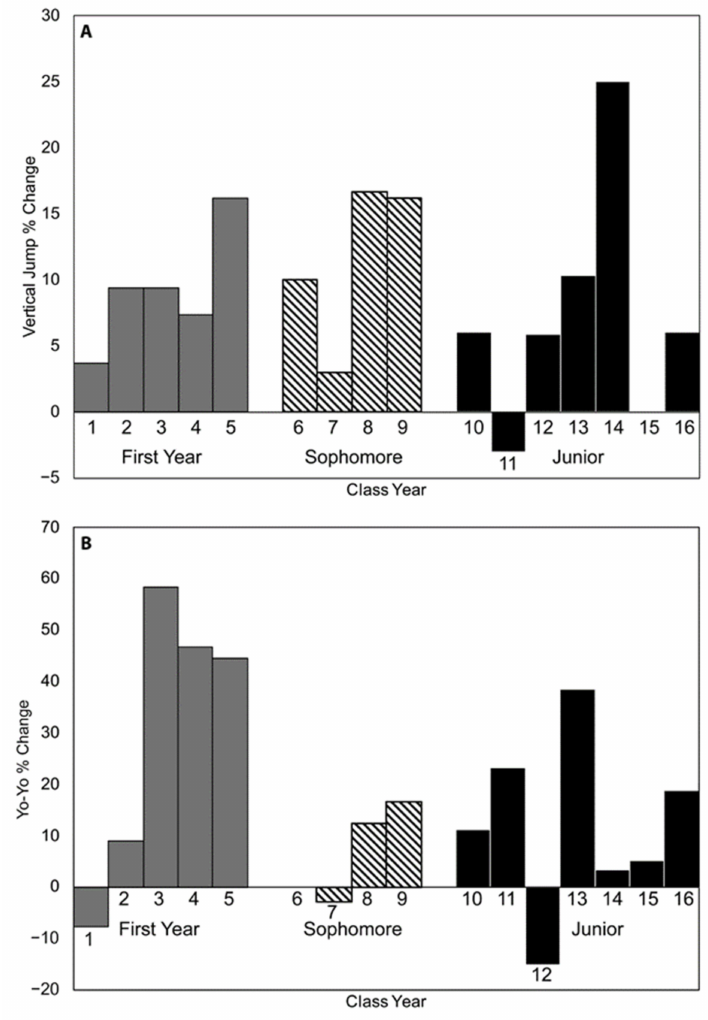
Figure 3. Percent change from pre season to post season for each individual player, grouped by class year for ( A ) vertical jump and ( B ) Yo-Yo IR1